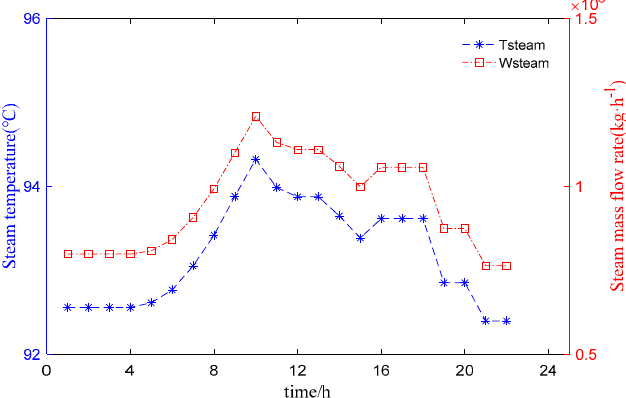
Figure 17. Trend of optimal operating parameters aiming at minimum TOC.